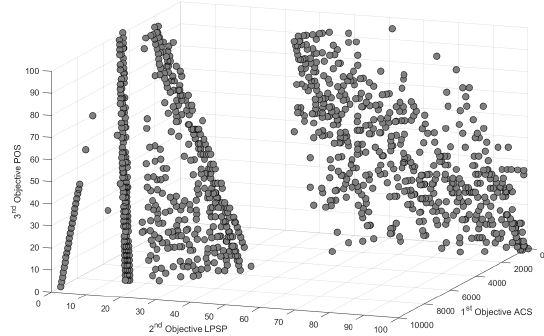
Figure 10. PF obtained by the PUSS model.